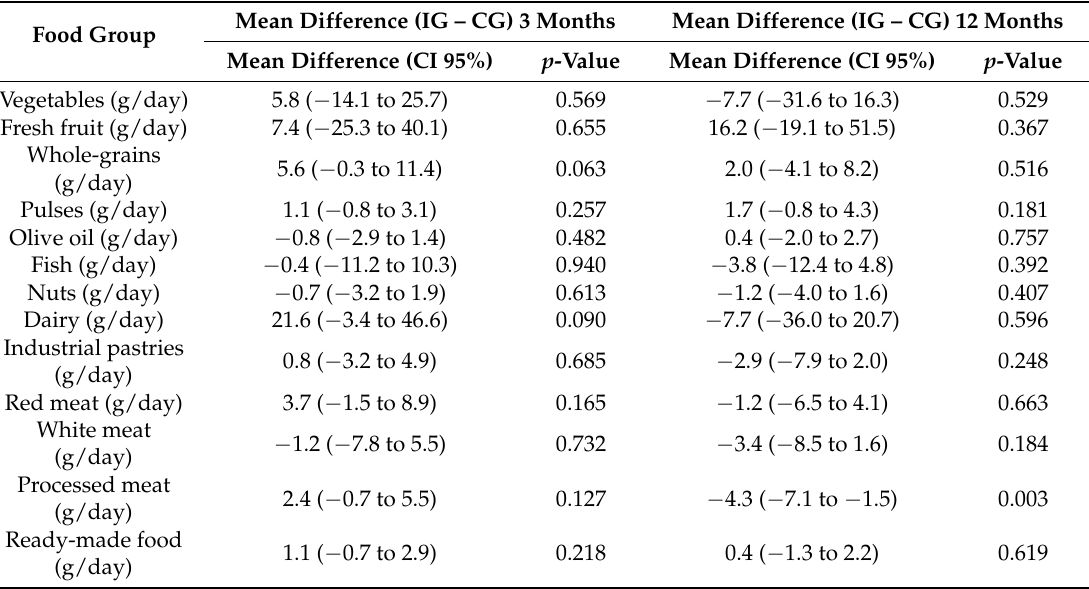
Table 5. Effect of the intervention in terms of variation in food